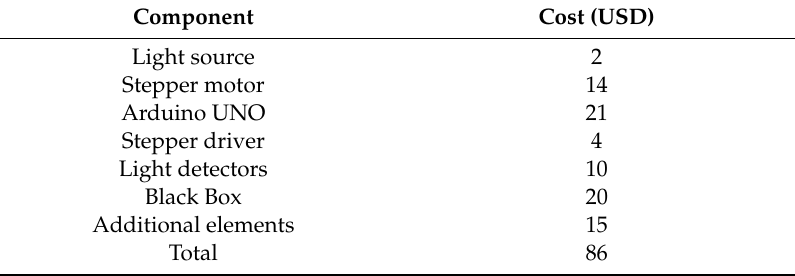
Table 6. Total cost of the developed spectrophotometer.